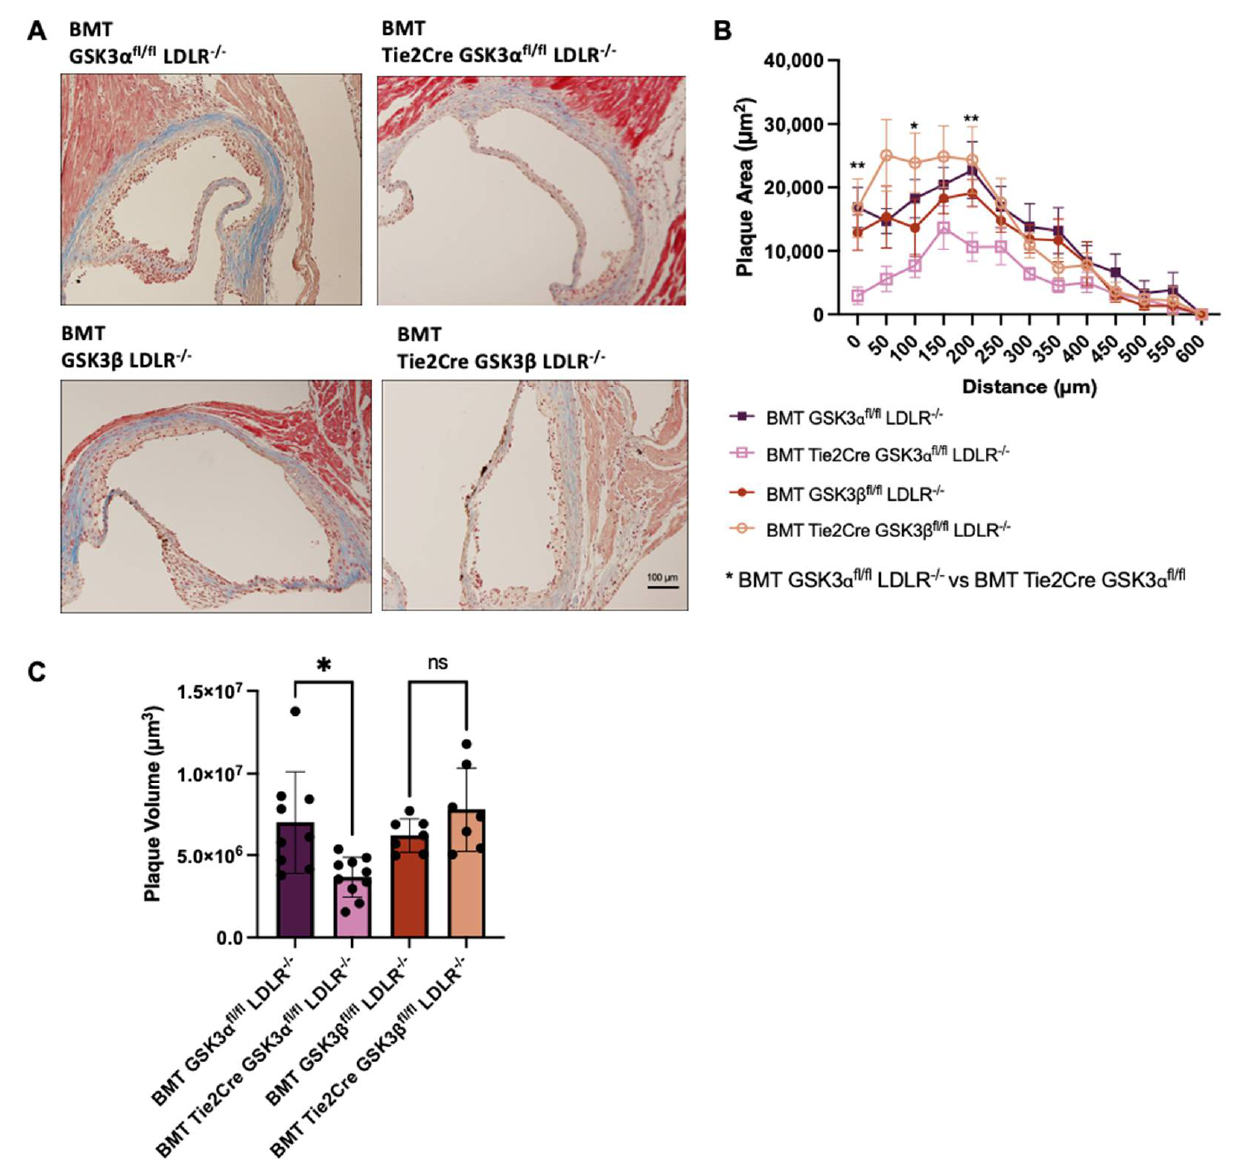
Figure 4. Atherosclerosis in BMT endothelial GSK3α/β knockout mice. ( A ) Representative images of Masson’s trichrome staining of cross sections of aortic sinus from 15 week old BMT control or BMT endothelial GSK3α/β knockout mice. Scale bar represents 100 μm. ( B ) Quantification of plaque area at the aortic sinus of the 15 week old mice. ( C ) Plaque volume quantification in the aortic sinus of BMT control and BMT endothelial GSK3α/β knockout mice. n = 7–10 ( B – C ), * p < 0.05, ** p < 0.05.